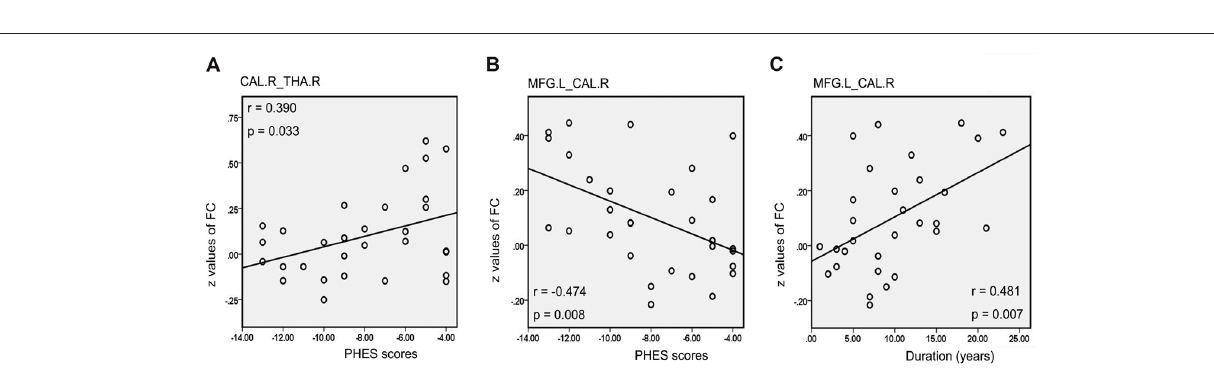
FIGURE 6 | Correlation between abnormal FC and clinical variables in cirrhotic patients with MHE. Significantly reduced z values of FC between the right calcarine (CAL.R) and right thalamus (THA.R) in the MHE group were positively correlated with poor PHES performance (A) . Within the visual network (VN) and dorsal attention network (DAN), the increased z values of FC between the CAL.R and MFG.L in MHE patients were negatively correlated with the PHES test scores (B) , but also negatively correlated with the disease duration (C) . A threshold of p < 0.05 was set without multiple comparison